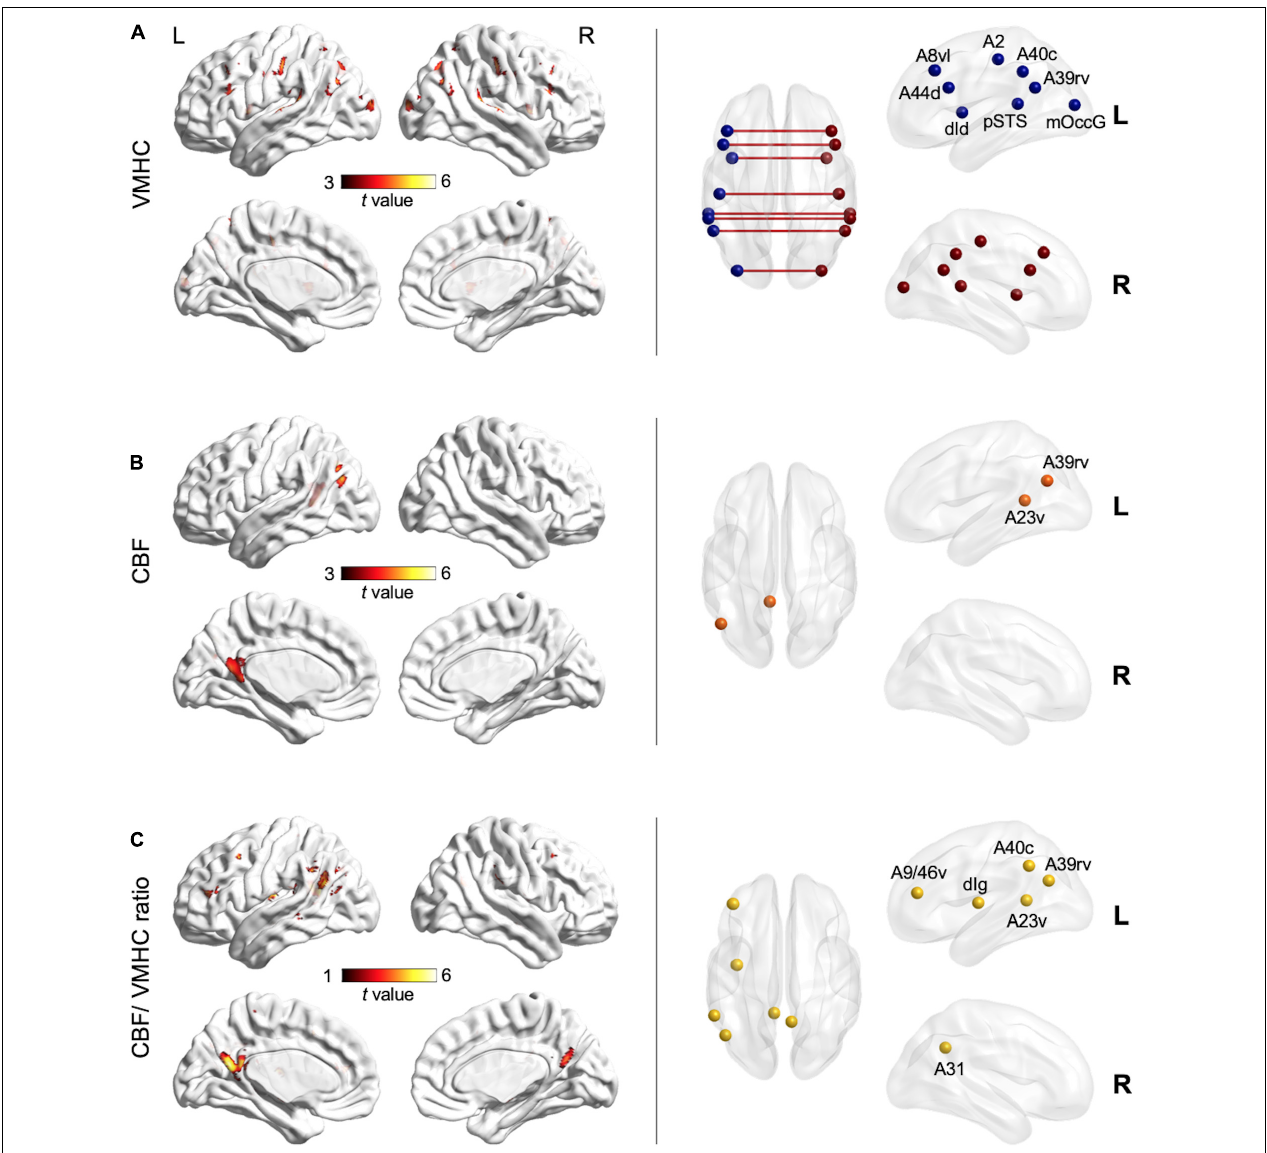
FIGURE 3 | Voxel-wise neurovascular comparisons between the aphasic group and control group (FDR-corrected p < 0.05) after controlling for age, sex, education level, and lesion size. Left column: clusters of warm colors indicate significant decreases in VMHC (A) , CBF (B) , and the CBF/VMHC ratio (C) in aphasia, respectively, with lighter colors denoting higher t -values and significance. Right column: nodes indicate subregions of the Brainnetome Atlas corresponding to significant clusters. A2, area 2; A23v, ventral area 23; A31, area 31; A39rv, rostroventral area; A40c, caudal area 40; A44d, dorsal area 44; A8vl, ventrolateral area 8; A9/46v, ventral area 9/46; CBF, cerebral blood flow; dId, dorsal dysgranular insula; dIg, dorsal granular insula; mOccG, middle occipital gyrus; pSTS, posterior superior temporal sulcus; VMHC, voxel-mirrored homotopic